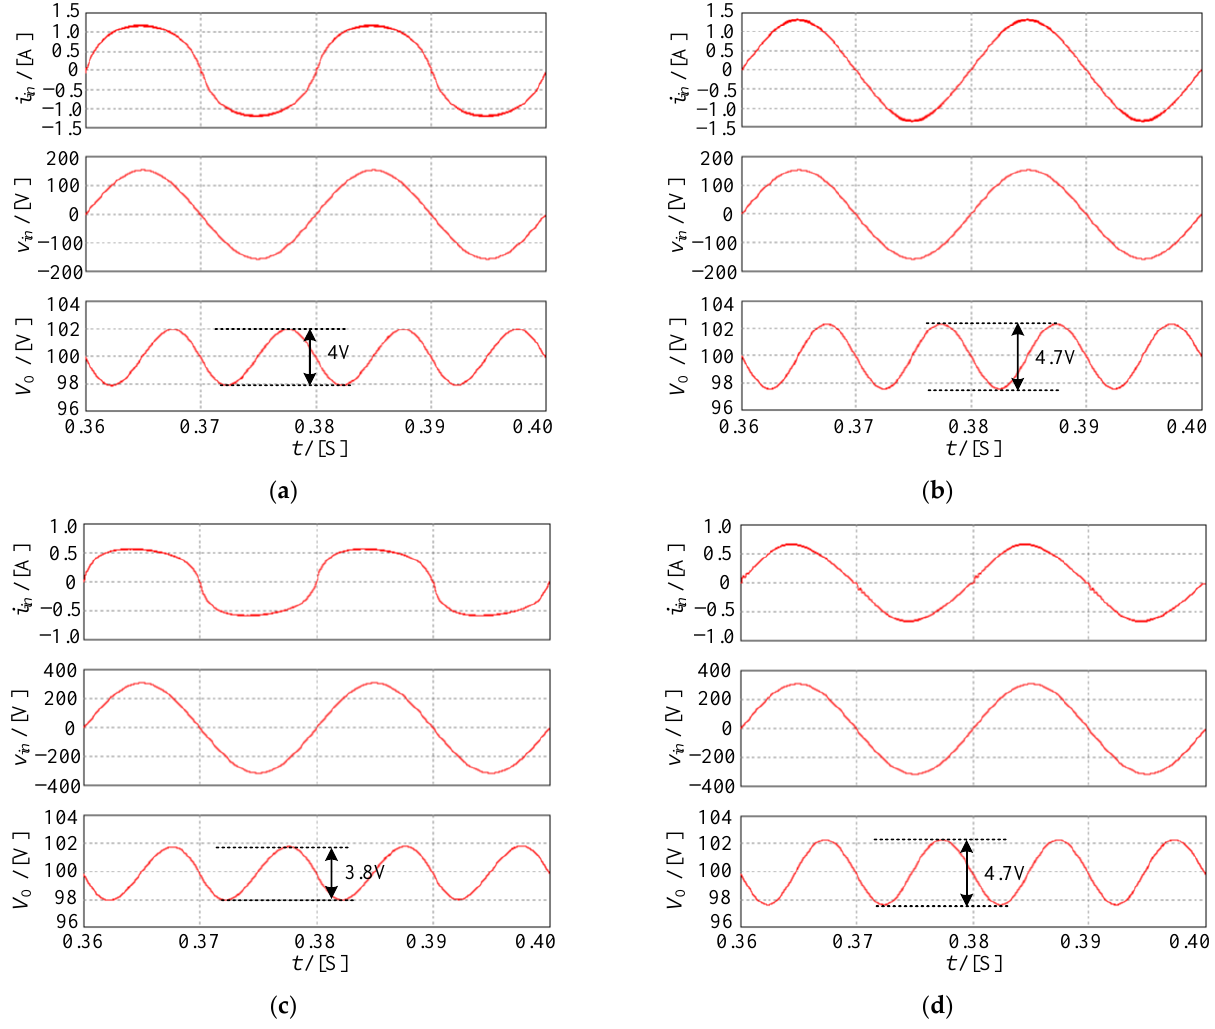
Figure 14. Simulation waveforms at rated load current with 110 Vac and 220 Vac input voltage. ( a ) COT with 110 Vac; ( b ) VOT with 110 Vac; ( c ) COT with 220 Vac; ( d ) VOT with 220 Vac.